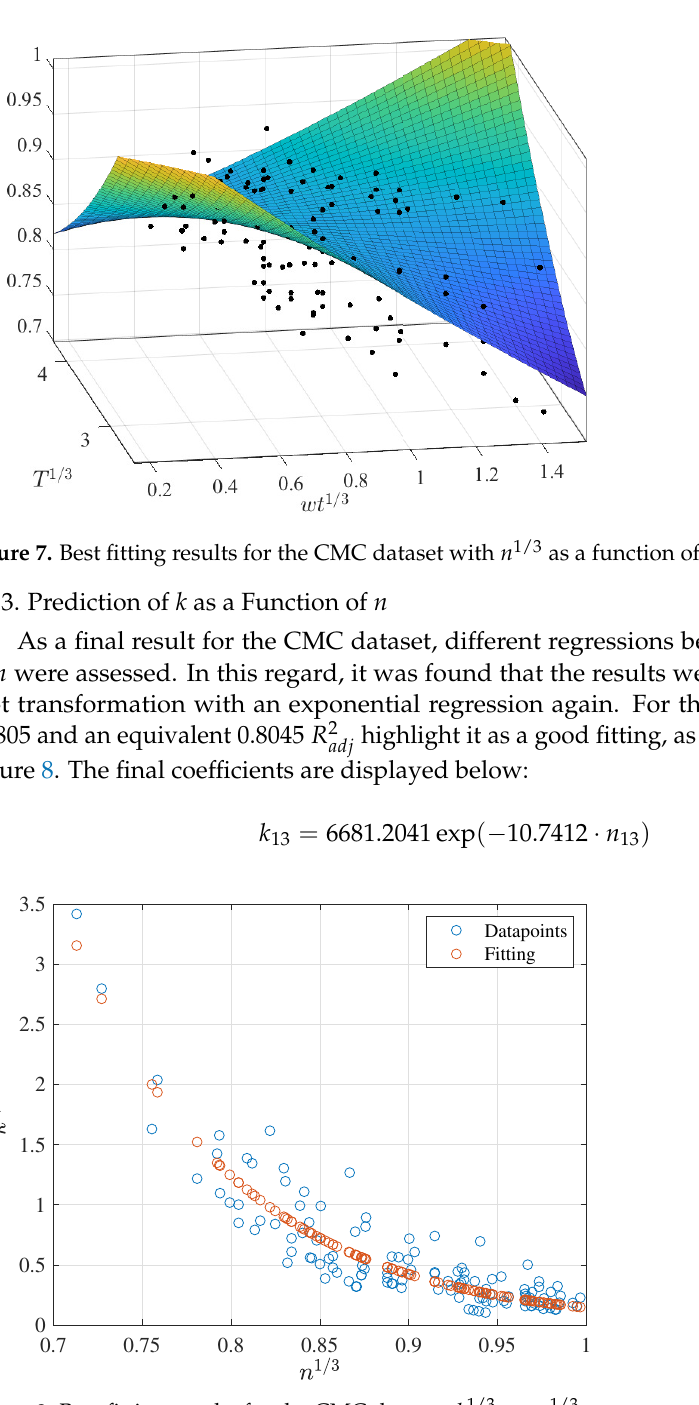
Figure 8. Best fitting results for the CMC dataset: k 1/3 vs. n